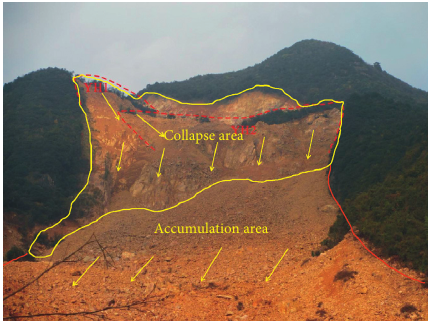
Figure 7: The source area is a “chair-like” topography after sliding at the Sucun landslide (it was taken on September 29, 2016, by the third geological team of the Zhejiang province).